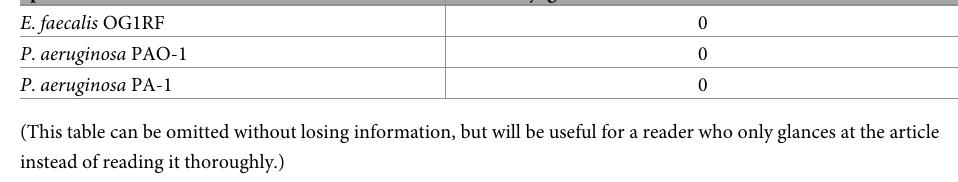
Table 2. Number of transconjugants found for transfer with E . coli ESBL 3170 as donor and E . faecalis OG1RF and two P . aeruginosa strains as recipient. Species